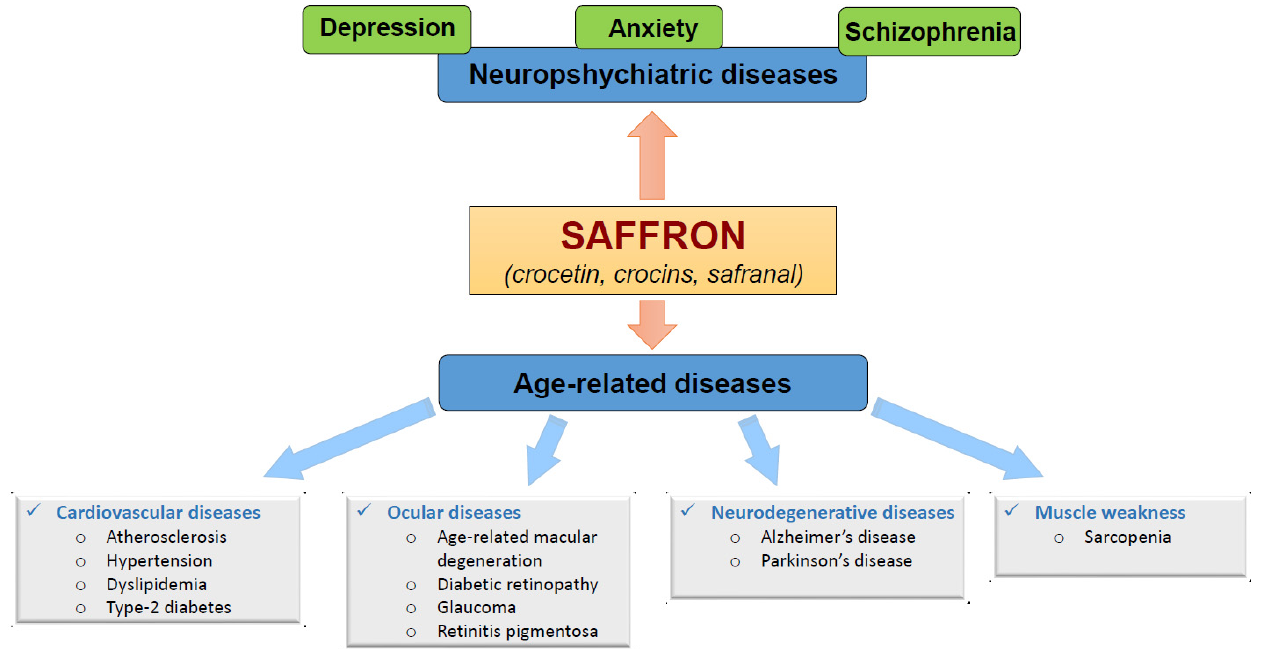
Figure 4. Beneficial effects of saffron constituents (crocetin, crocins and safranal) on neuropsychiatric and age-related diseases.